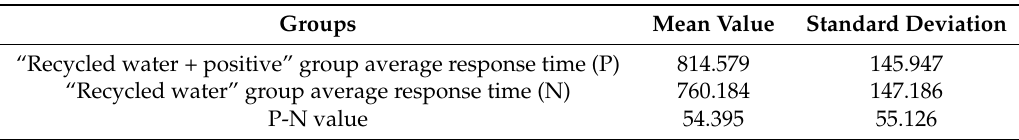
Table 3. Experimental data summarization of the baseline